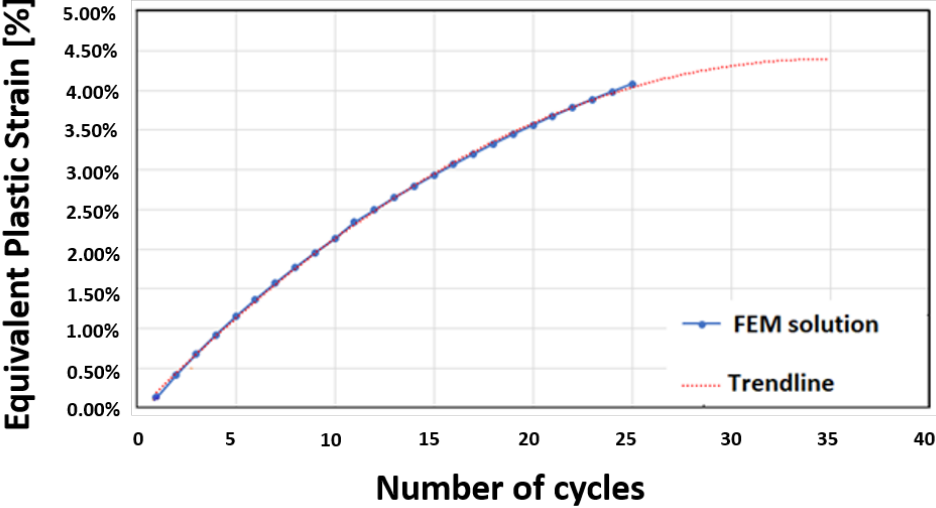
Figure 15. Equivalent plastic strain evolution with number of cycles.